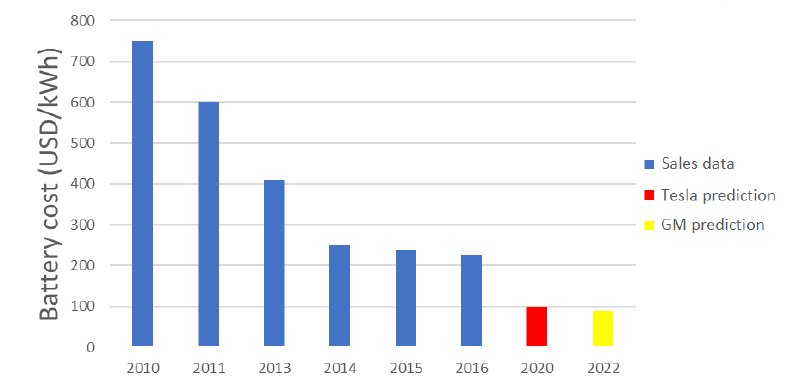
Figure 7. Battery prices, derived form